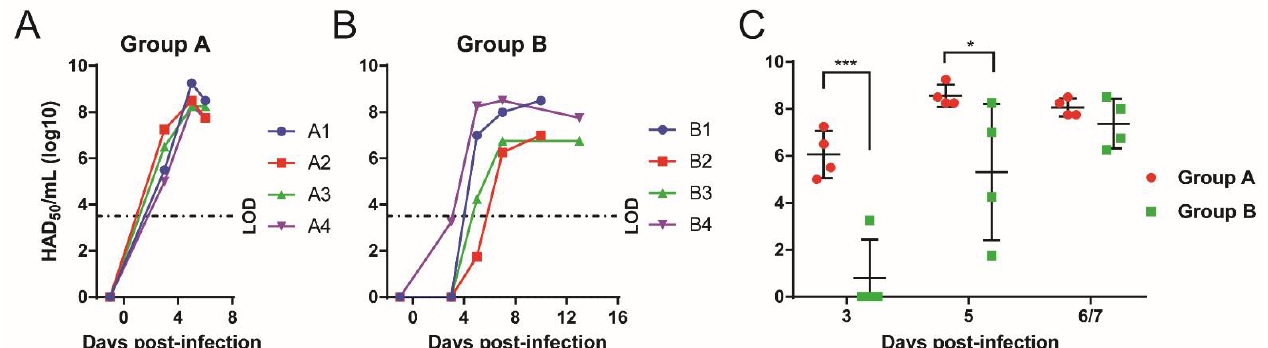
Figure 5. Viremia levels of pigs. Levels of infectious virus were measured for pigs immunized with ( A ) Georgia∆DP148R and ( B ) Georgia∆K145R∆DP148R via titrations of blood after inoculation. The limit of detection (LOD) using this method is 3.16 × 10 3 HAD 50 /mL. ( C ) Comparison of the infectious virus levels between Group A and B at the early days of infection. A two-way ANOVA with Sidak’s multiple comparisons test was performed, to evaluate the differences in the levels of viruses over days of infection. Significant difference is represented by asterisk(s); differences are represented by asterisk(s) where * is p < 0.05 and *** is p < 0.001.